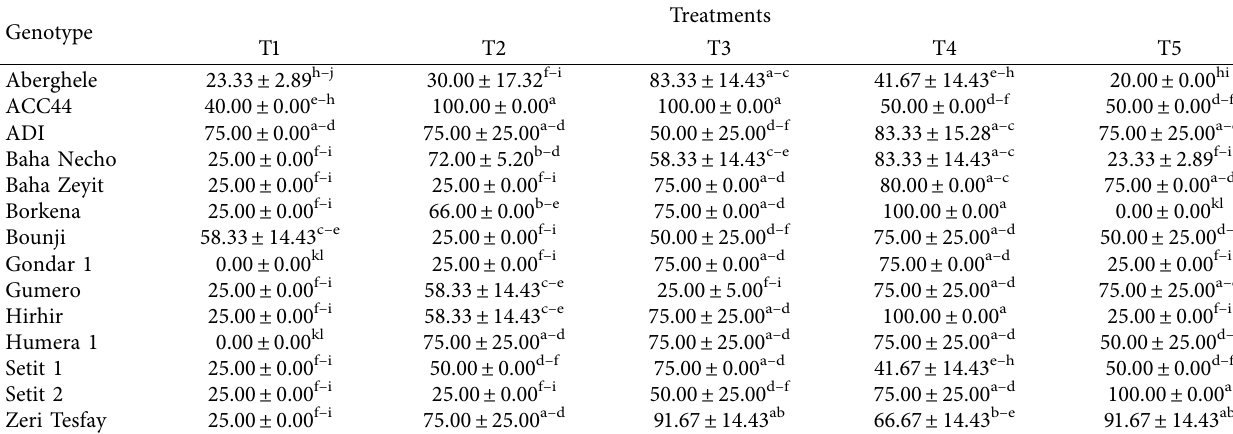
Table 7: Interaction effects of IBA and NAA supplements and genotypes on rooting response.